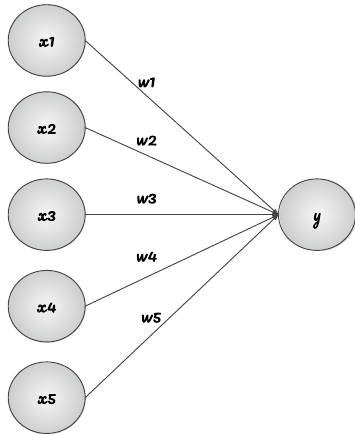
Figure 1. A pictorial representation of how a neuron of one layer connects with neurons of other layer.